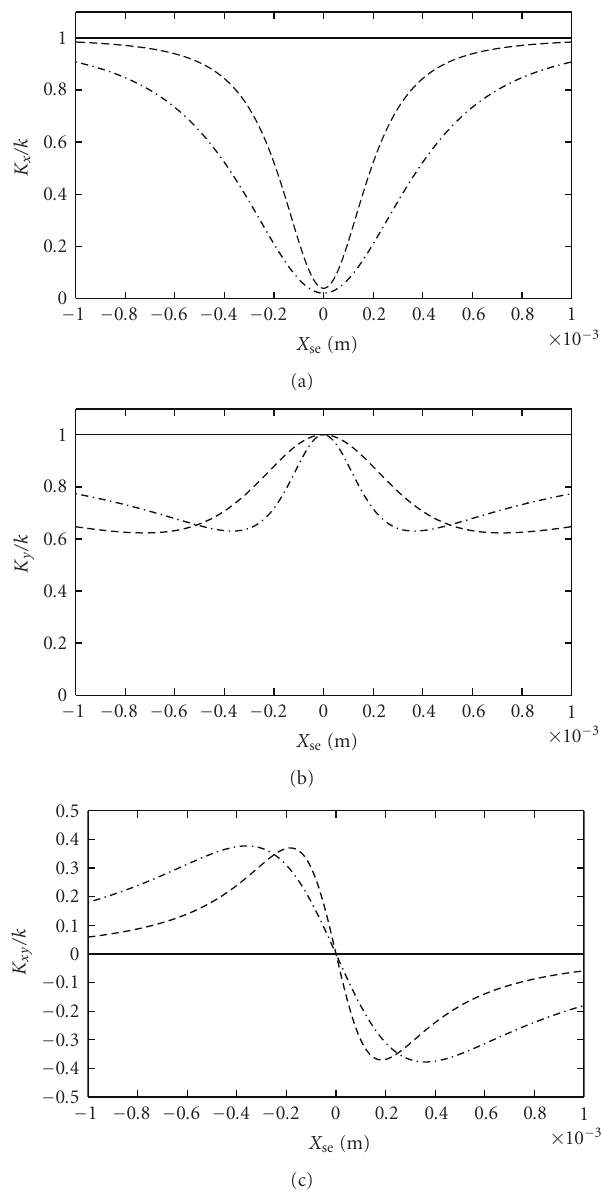
Figure 2: Approximated pedestal sti ff ness coe ffi cient ratios.